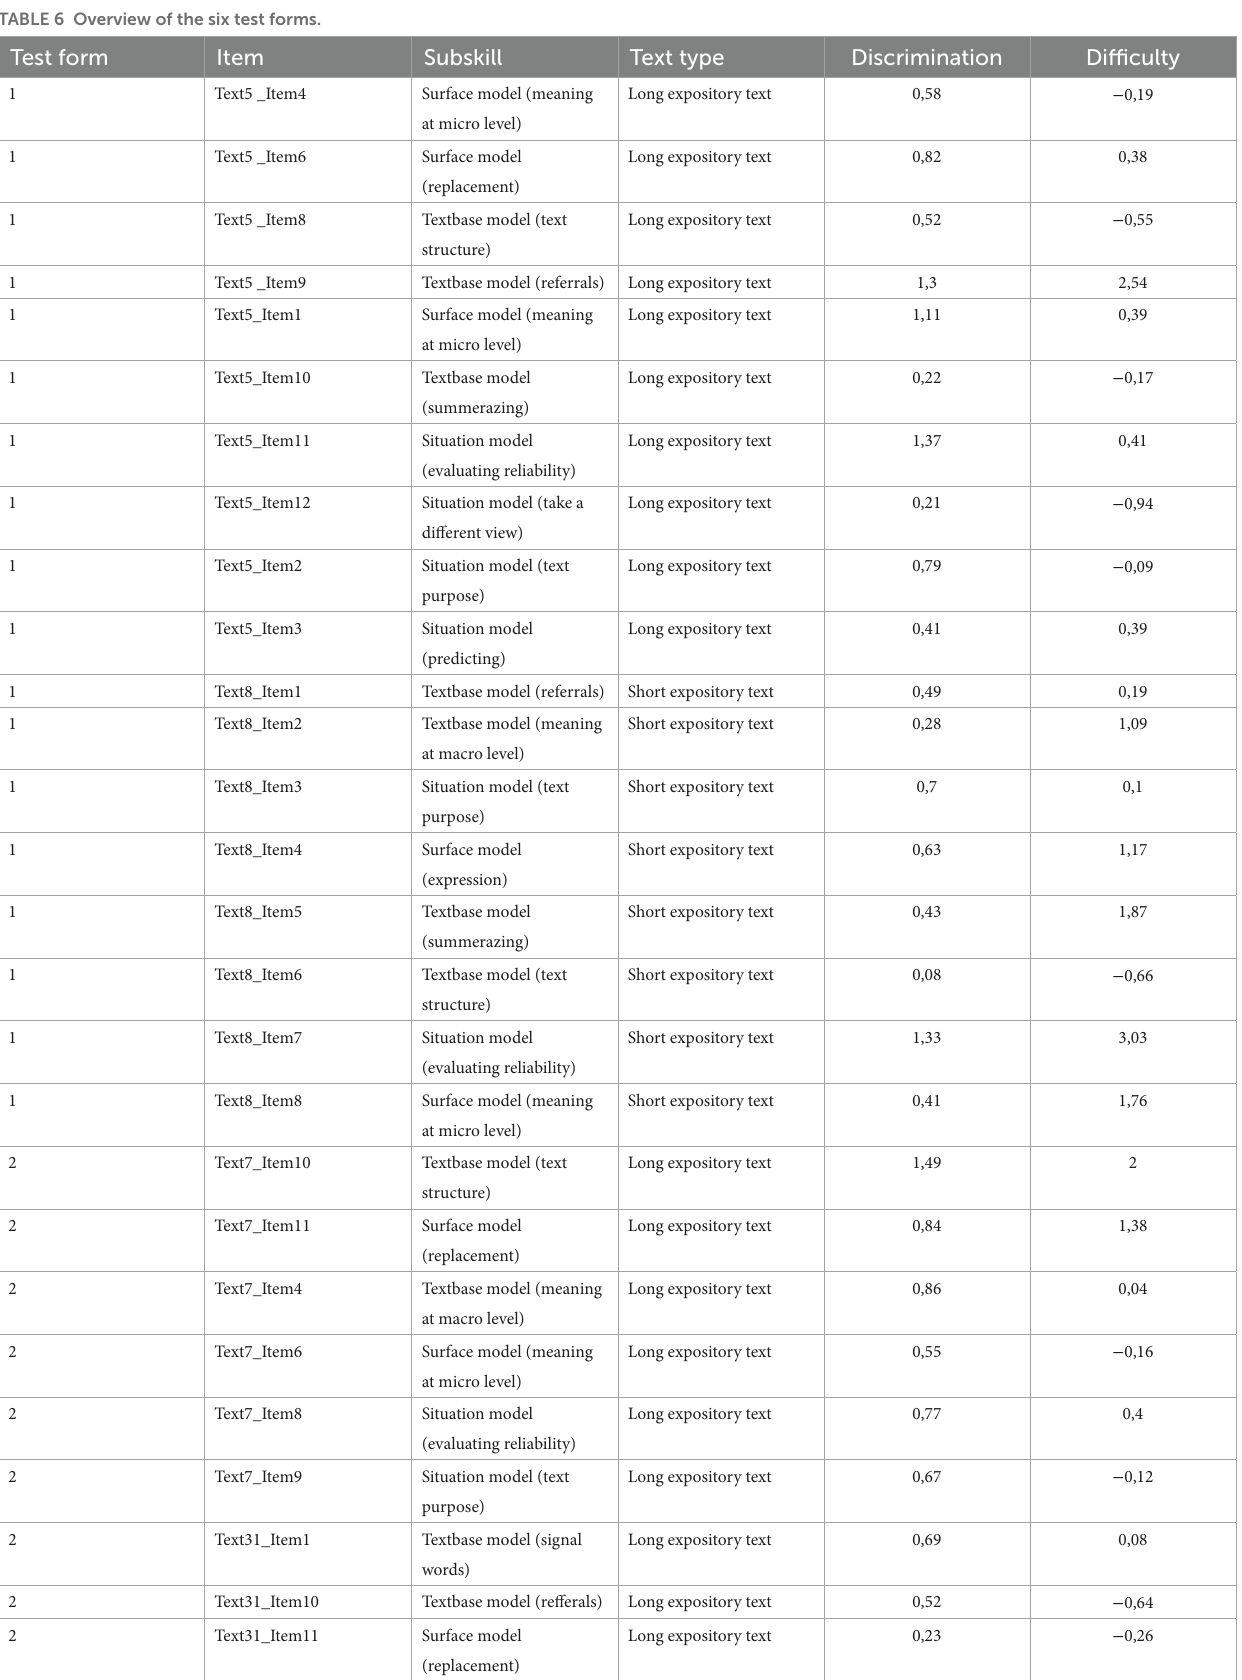
TABLE 6 Overview of the six test